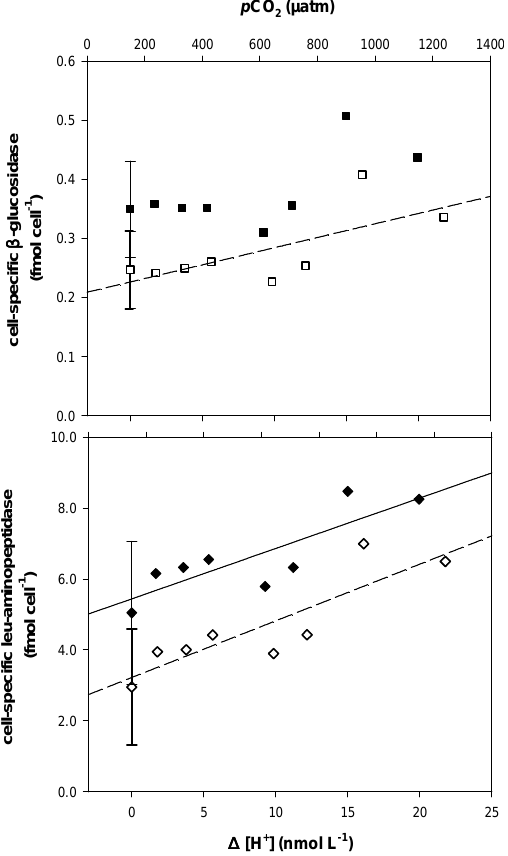
Fig. 10. Relationships between seawater p CO 2 /delta proton con- centration ( 1 [H + ]) and cell-specific extracellular enzyme activ- ities. Separate correlations are shown for rates integrated over days 4–20 (open symbols) and the whole experiment (filled sym- bols). Lines represent significant ( p < 0.05) linear regressions ( β - glucosidase, d 4–20: r 2 = 0 . 53; leu-aminopeptidase, d 4–20: r 2 = 0 . 79, whole experiment: r 2 = 0 . 57).